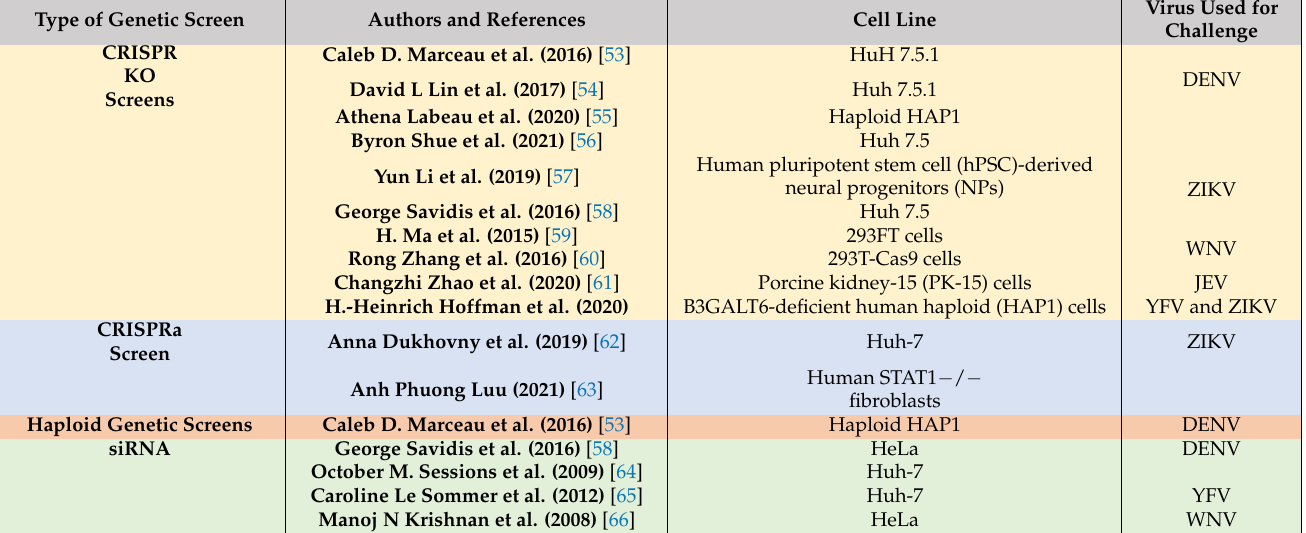
Table 1. Summary of Genome-Wide Genetic Screens to uncover host dependency and restriction factors for